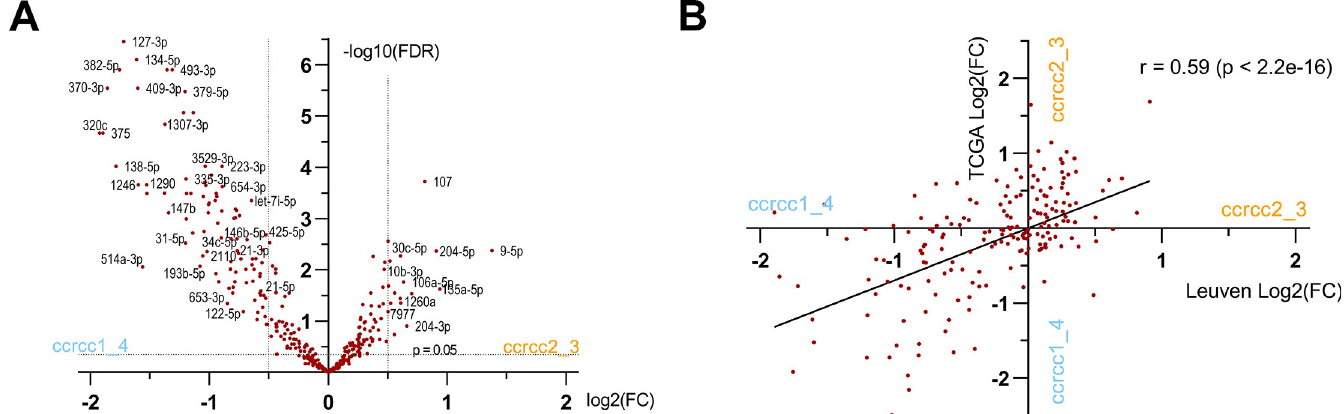
Fig 2. Illustration of subtype-specific miRNA expression. Ccrcc2_3 and ccrcc1_4 tumors showed distinct miRNA expression patterns. (A) Volcano plot of miRNAs with subtype-specific expression (Leuven dataset, n = 95). (B) Subtype-specific miRNA expression in the Leuven dataset was validated on TCGA by Pearson correlation (r = 0.59) (n = 95 Leuven and n = 107 TCGA). The correlation was performed on 189 miRNAs that were shared between the Leuven and TCGA dataset. FC = fold change; FDR = false discovery rate.